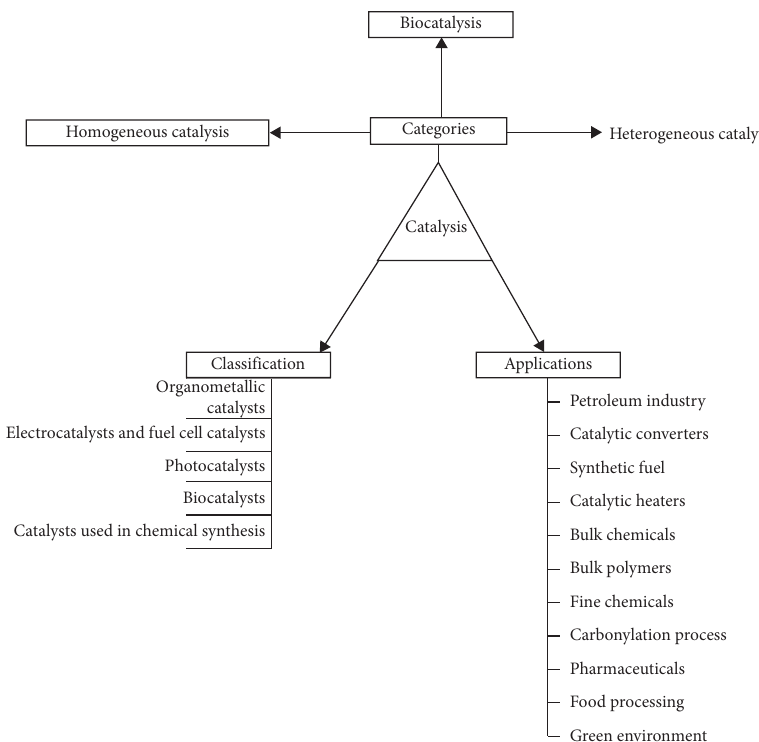
Figure 1: Categories, classification, and applications of